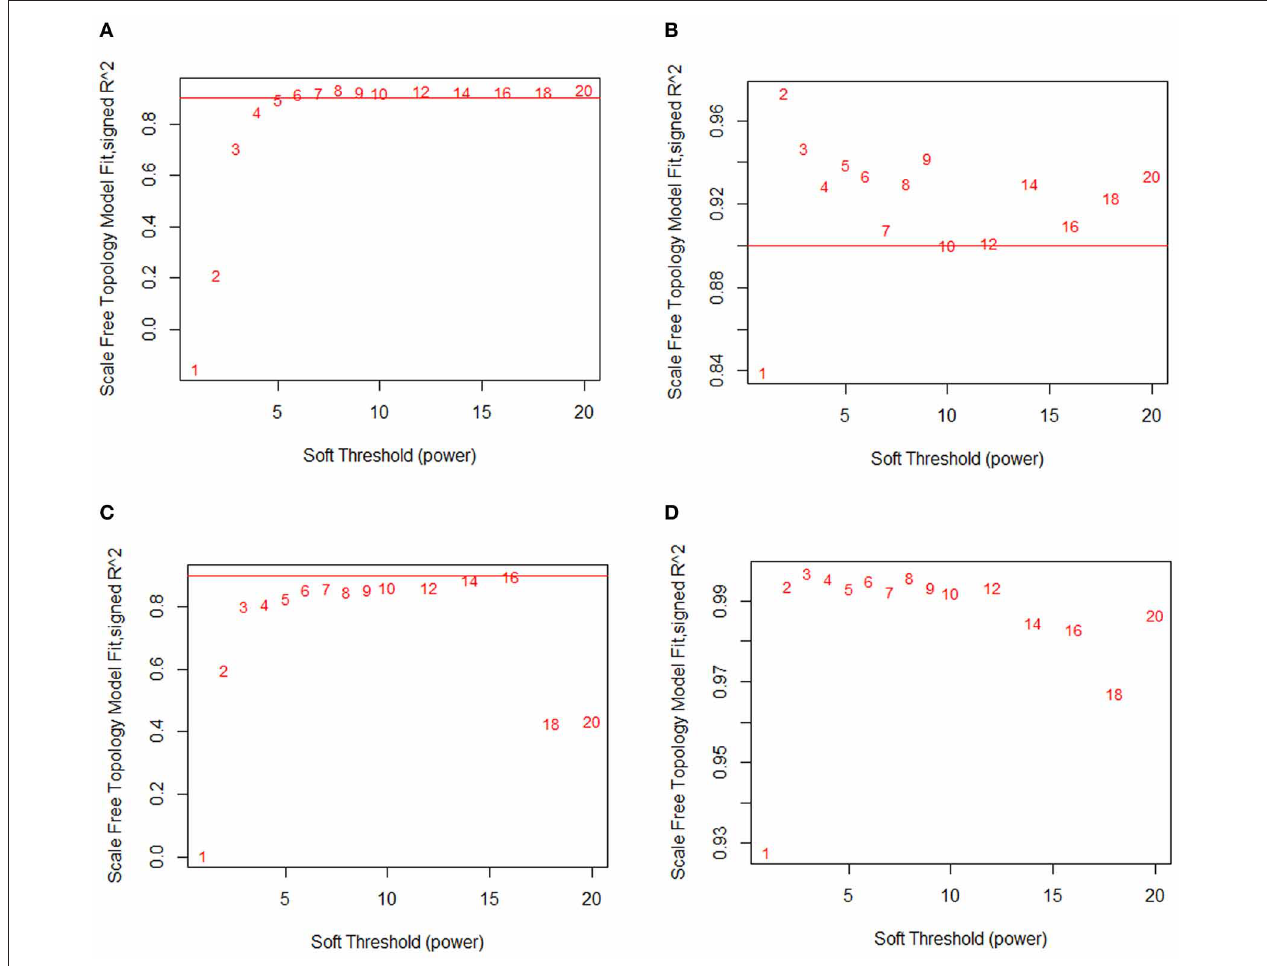
FIGURE 3 | MINE returns a scale-free network structure. Scale-free topology fits at various powers of the relationship matrix. (A) Macrophage and Pearson correlation. (B) Macrophage and MINE. (C) Liver and Pearson